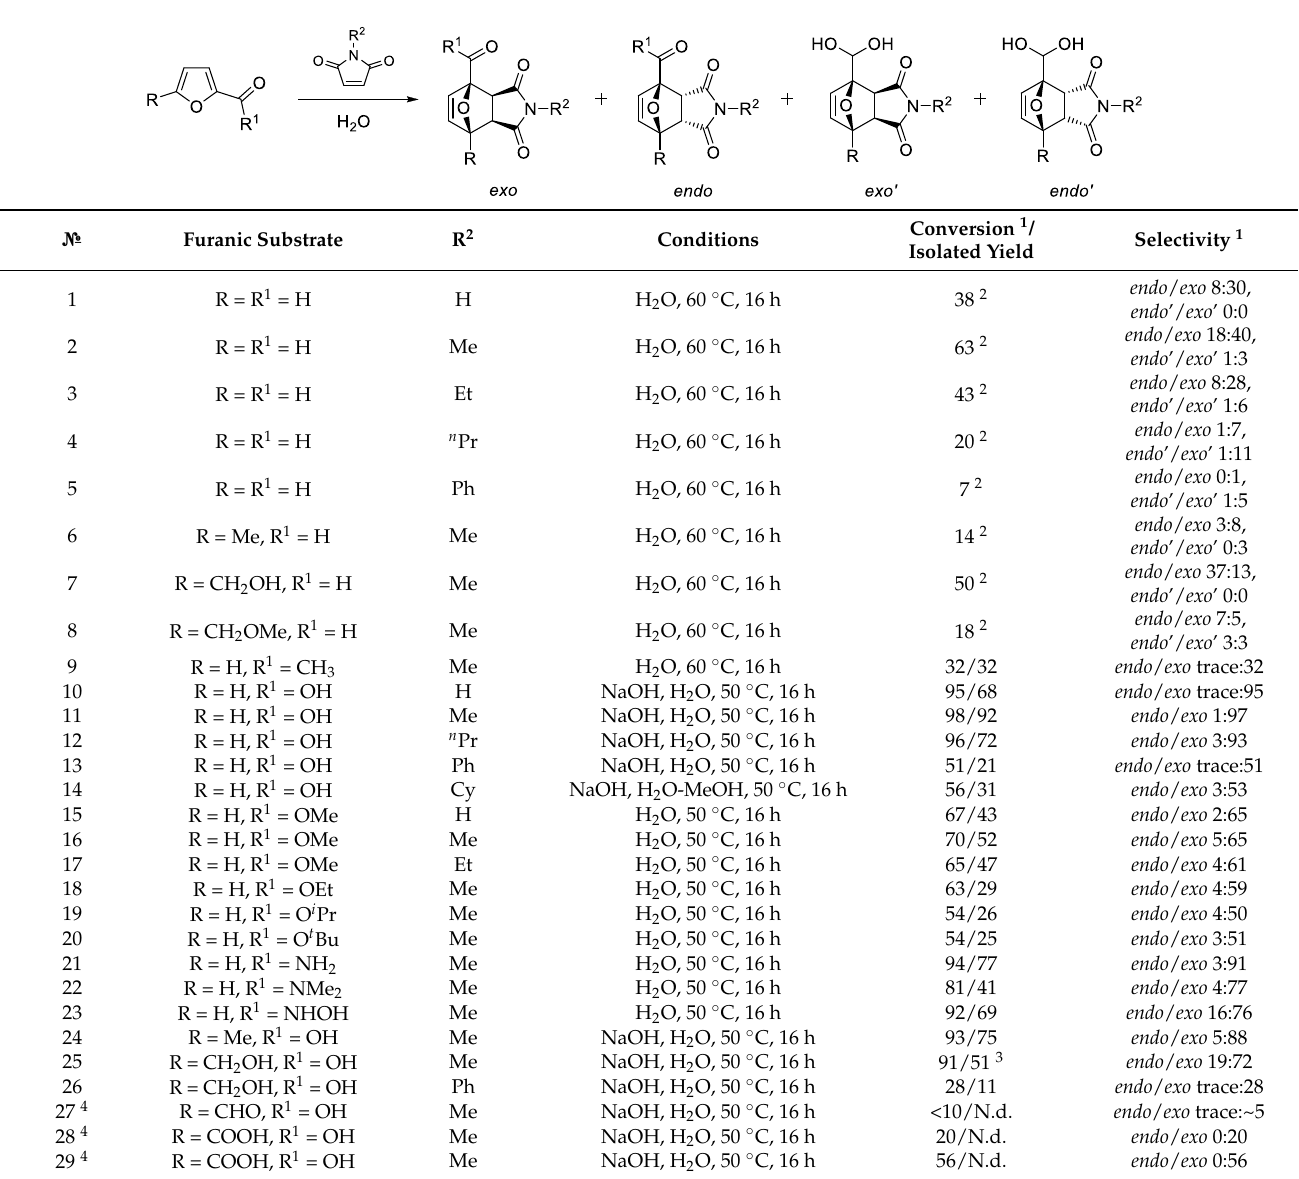
Table 3. The results of water-mediated DA cycloadditions of acceptor-substituted furans with maleimides.